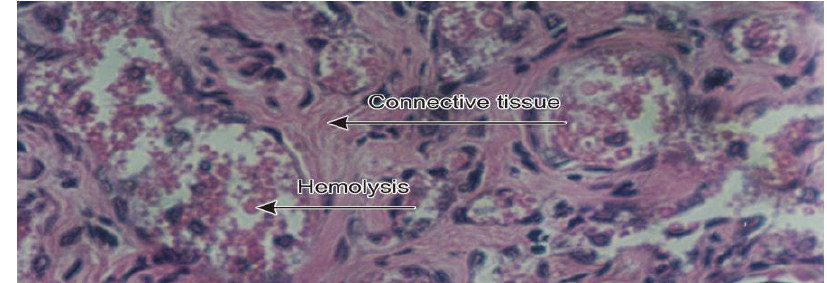
Figure – 1: Cross section from preputial gland in castrated rat showing increase in connective tissue and scattered hemorrhage ( H&E stain, X40).